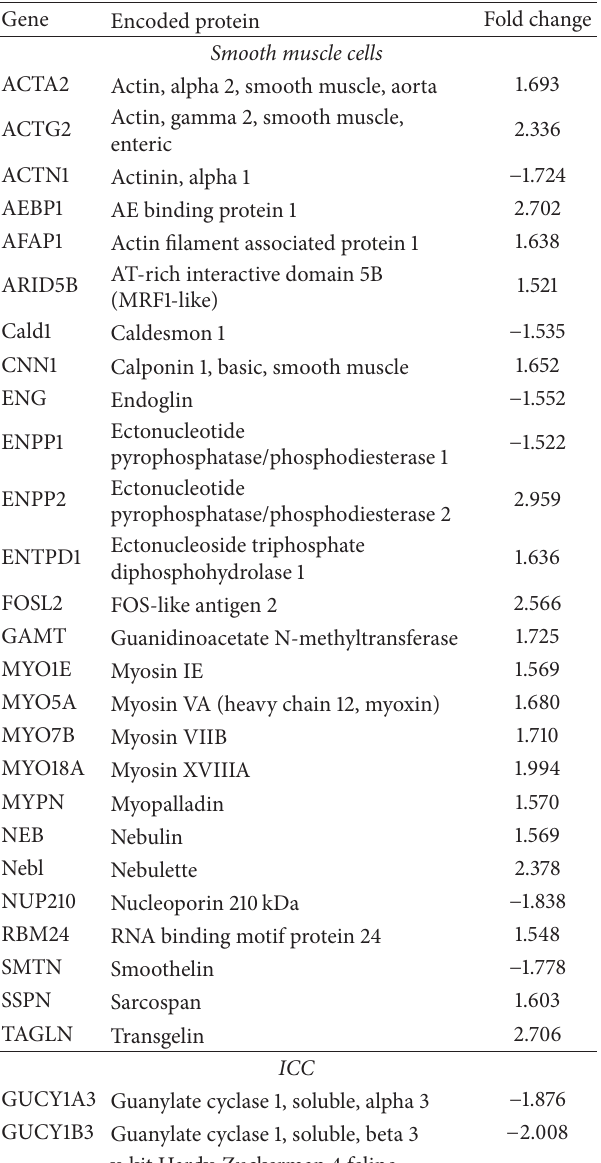
Table 3: Differentiation of smooth muscle